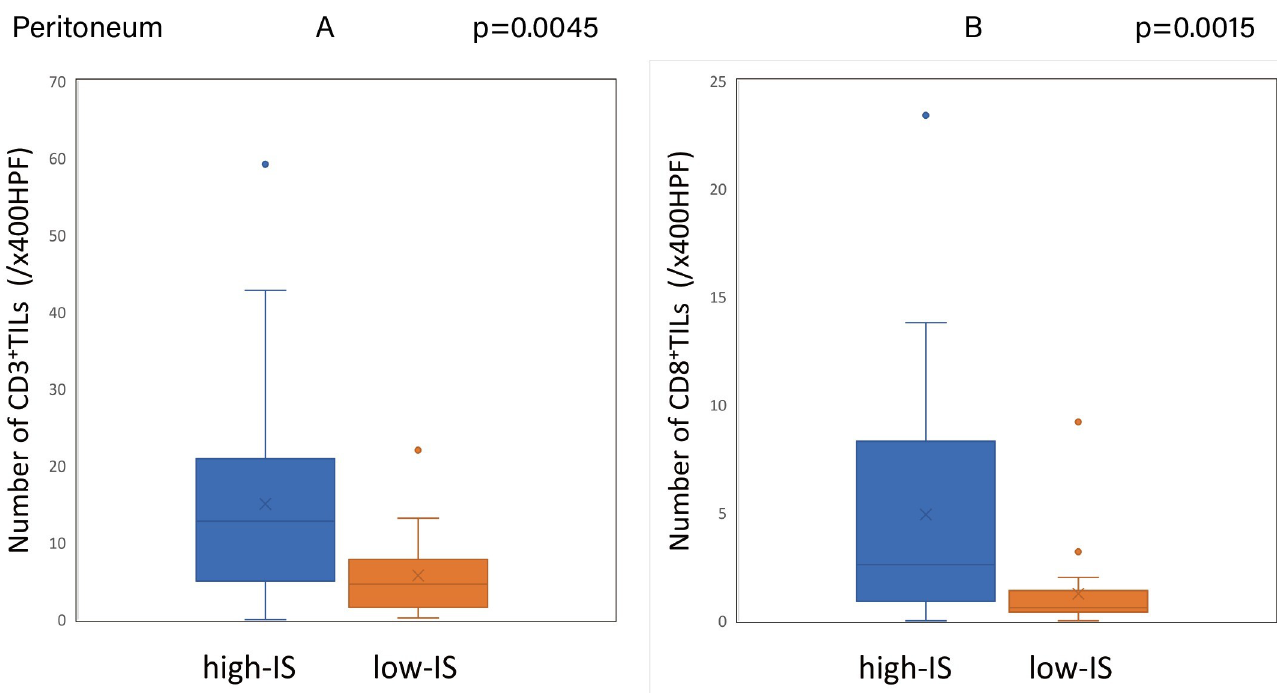
Fig 9. Relationship between the Immunoscore of primary tumors and the degree of TIL infiltration in the peritoneal metastases. (A) (B) The density of tumor-infiltrating lymphocytes in peritoneal metastases with high-Immunoscore primary tumors was significantly higher than that with low-Immunoscore primary tumors (CD3: p = 0.0045, CD8: p =